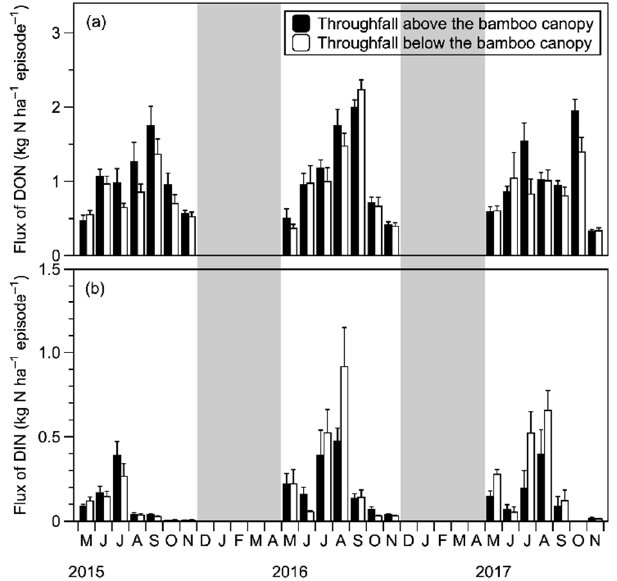
Figure 7. Average flux (kg N ha − 1 episode − 1 ) of dissolved organic nitrogen (DON) ( a ) and dissolved inorganic nitrogen (DIN) ( b ) in throughfall above and below the bamboo canopy from May 2015 to November 2017. Shaded areas show the snow seasons. Error bars show the standard error ( n = 9).